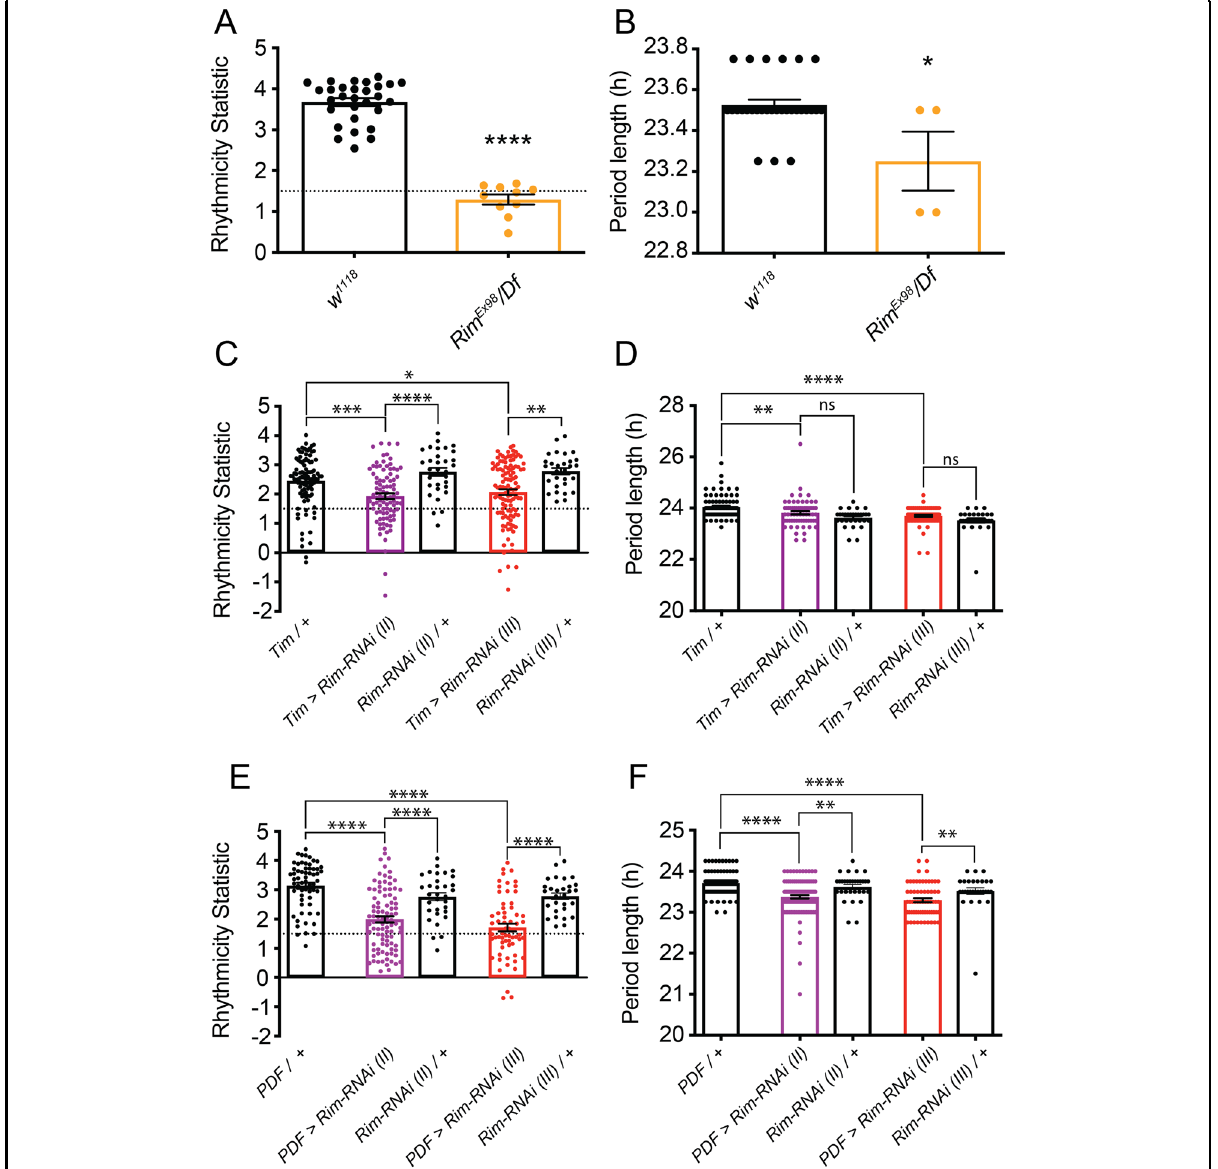
Fig. 3 Rim knockdown in the clock network reduced rhythmicity and shortened period length under constant darkness (DD). The rhythmicity statistic (RS), as a measure of rhythm strength and the free-running period length of the circadian rhythm, was determined over 5 days in DD. A Rim Ex98 /Df mutants showed a reduction in RS (orange bar; the dotted line shows RS = 1.5, fl ies with RS above that line are considered rhythmic), and B shorter period (orange bar) compared to control fl ies (open black bars). C To map this phenotype, Rim was knocked down throughout the clock, resulting in a signi fi cant reduction in rhythm strength and D shortening of the period compared to Tim / + control. E Restricted expression of Rim-RNAi to just a dozen PDF-positive LNvs replicated the reduction in rhythm strength and F lengthening of the period in PDF>Rim- RNAi compared to control fl ies. Unpaired t -test was conducted for data in A and B . Kruskal – Wallis test was conducted for data in C , D and F with Dunn ’ s post hoc test. One-way ANOVA with Holm – Sidak ’ s post hoc test. n ( w 1118 ) = 29, n ( Rim Ex98 /Df ) = 10, n ( Tim / + ) = 95, n ( Tim>Rim-RNAi (II) ) = 92, n ( Tim>Rim-RNAi (III) ) = 114, n ( PDF / + ) = 61, n ( PDF>Rim-RNAi (II) ) = 94, n ( PDF>Rim-RNAi (III) ) = 63, n ( Rim-RNAi (II) / + ) = 32 and n ( Rim-RNAi (II) / + ) = 29 fl